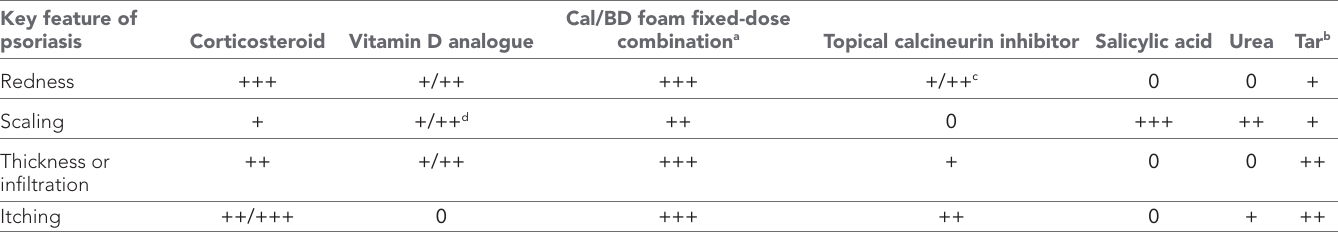
Table 5 Clinical effectiveness of topical treatments on psoriasis symptoms Key feature of